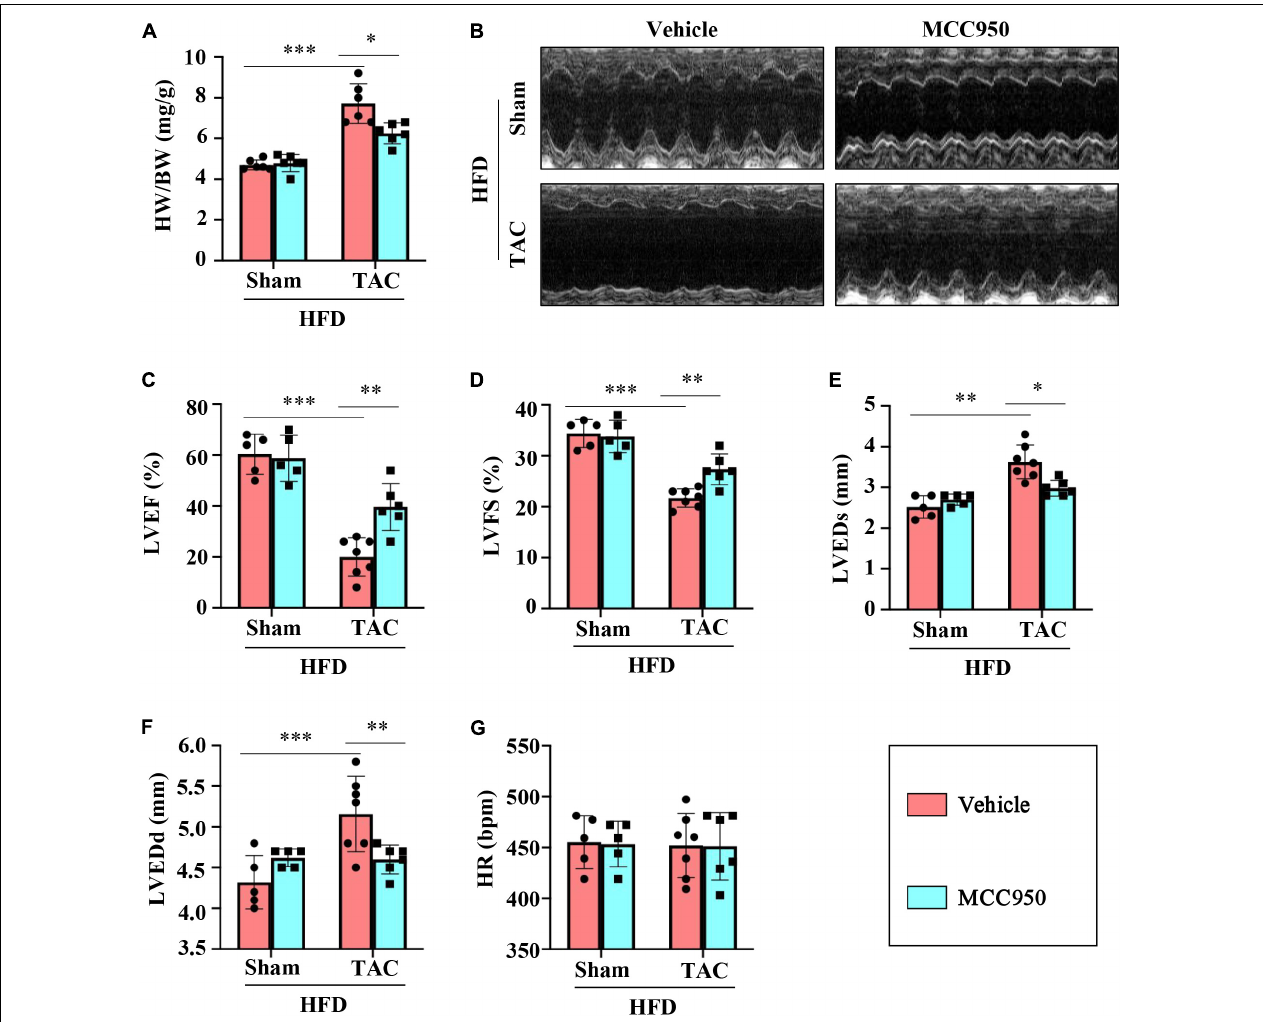
FIGURE 1 | MCC950 reversed the cardiac dysfunction post-TAC. (A) The ratio of heart weight (HW)/body weight (BW) in different groups, n = 6. (B) Representative images of echocardiography. (C–G) Echocardiography measurements of LVEDd, LVEDs, LVEF, LVFS, and HR, respectively, n = 6. LVEF, left ventricle ejection fraction; LVFS, left ventricle fractional shortening; LVEDs, LV end-systolic diameter; LVEDd, LV end-diastolic diameter; HR, heart rate. ∗ p < 0.05, ∗∗ p < 0.01, ∗∗∗ p < 0.001.